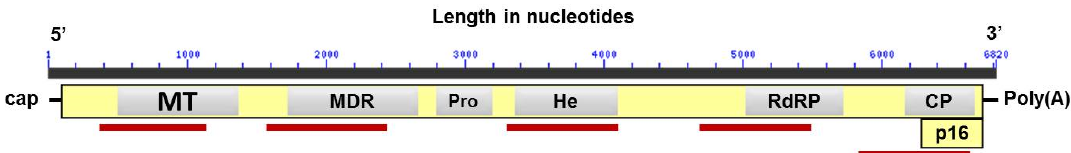
Figure 1. Genome organization of CSDaV. The two ORFs are represented by yellow boxes and the conserved domains are represented by grey boxes. Red bars indicate the genomic regions analyzed in this study.